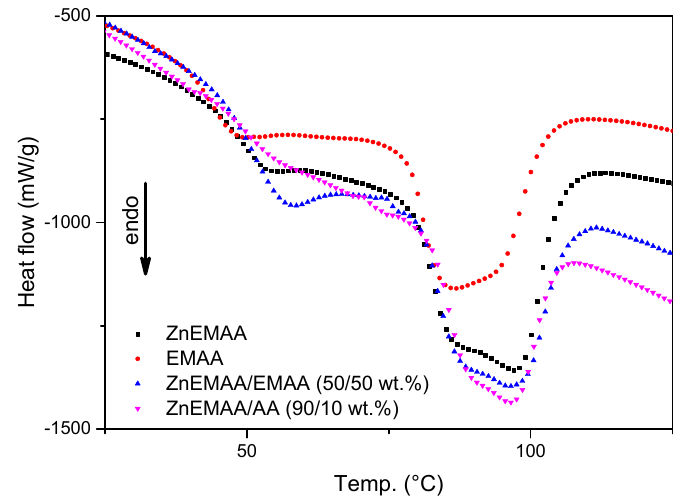
Figure 1. DSC thermograms for four particulate polymer blends showing the effect of ionic cluster content on the low-temperature endotherm in the melting range of the polymer composites.